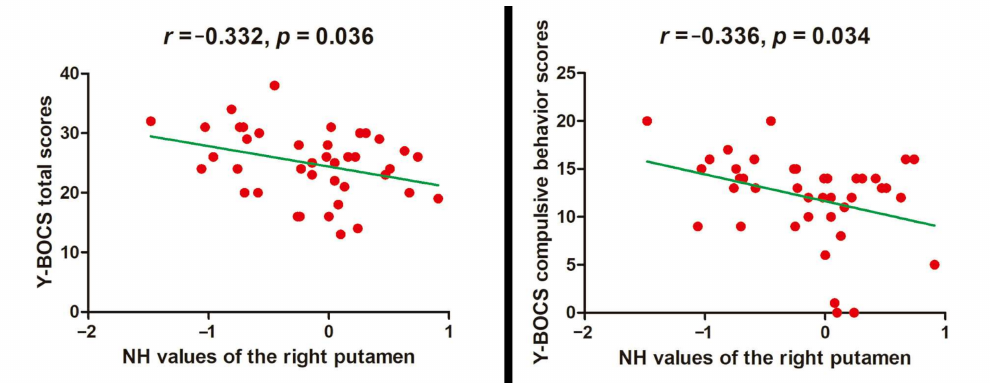
Figure 3. Relationship between NH values and clinical characteristics in OCD. NH = network homo- geneity, OCD = obsessive–compulsive disorder, Y-BOCS = Yale–Brown Obsessive–compulsive